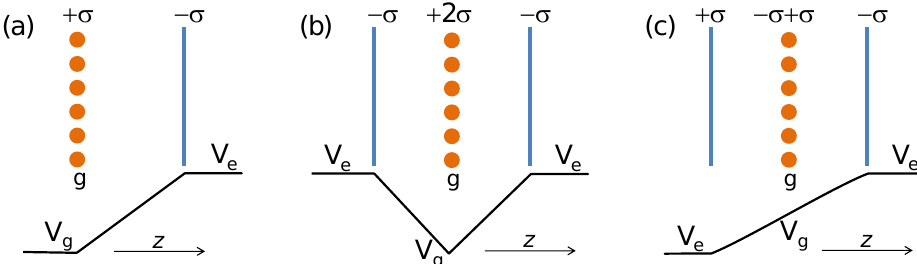
Figure 1. Schematic illustration of three geometries considered in this work of a graphene sheet (solid circles) interacting with an external electric charge uniformly distributed in the x - y plane with density − σ at a chosen distance in the z direction.In the geometry ( a ) this extra charge is placed on the right. In the case ( b ) the charges of the same signs are located on the left and right sides. Panel ( c ) illustrates the geometry when the charges of the opposite sings placed on each